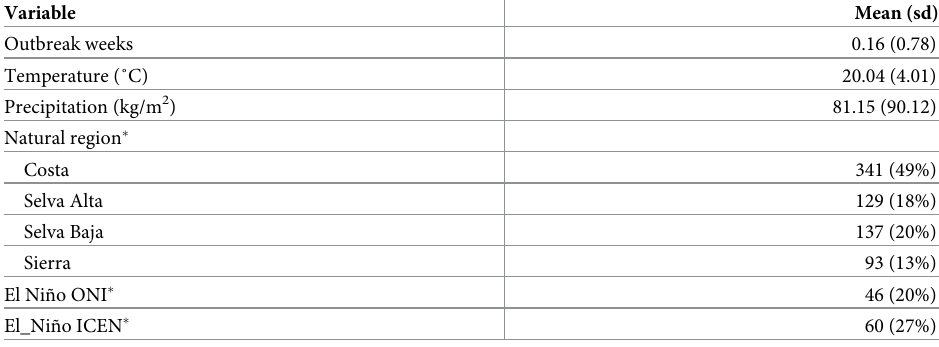
Table 1. Descriptive statistics after merging formed districts and eliminating districts with elevation > 2,500 meters (n = 701) January 2000-September 2018. Mean was taken over district-months for outbreak weeks, tempera- ture, and precipitation; over districts for region; and over months for El Ni ñ o variables.